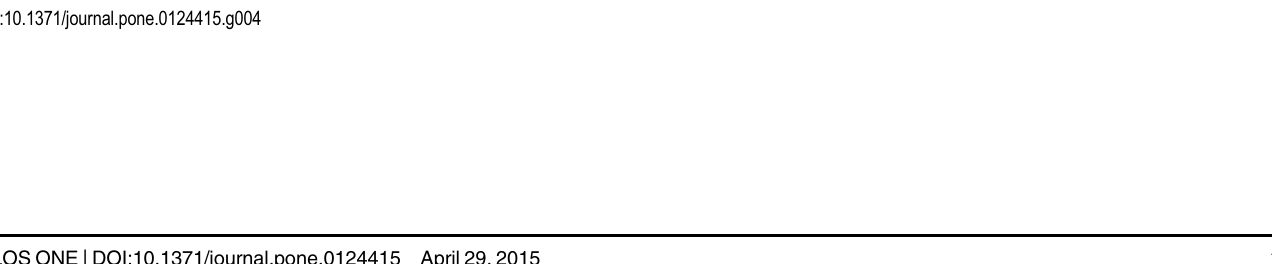
PLOS ONE | DOI:10.1371/journal.pone.0124415 April 29,